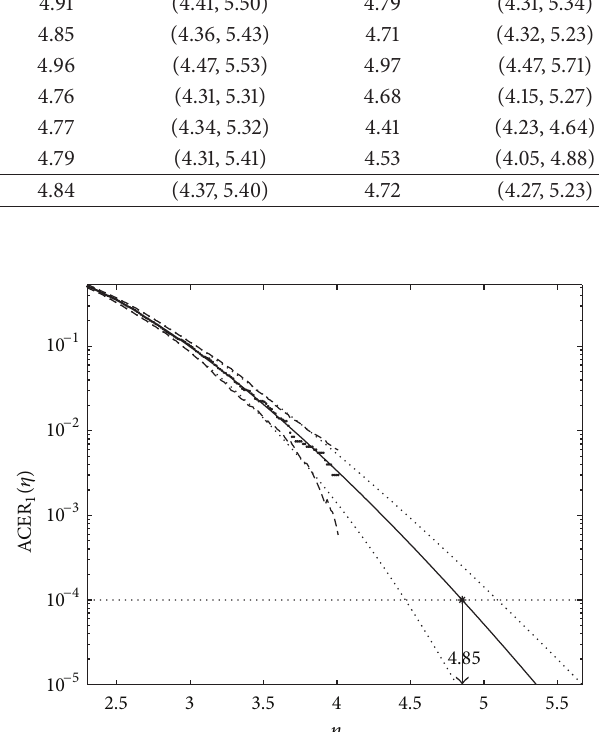
Figure 1: Synthetic data ACER ̂𝜀 1 , Monte Carlo simulation ( ∗ ); optimized curve fit (—); empirical 95% confidence band (--); optimized confidence band ( ⋅⋅⋅ ). Tail marker 𝜂 1 = 2.3